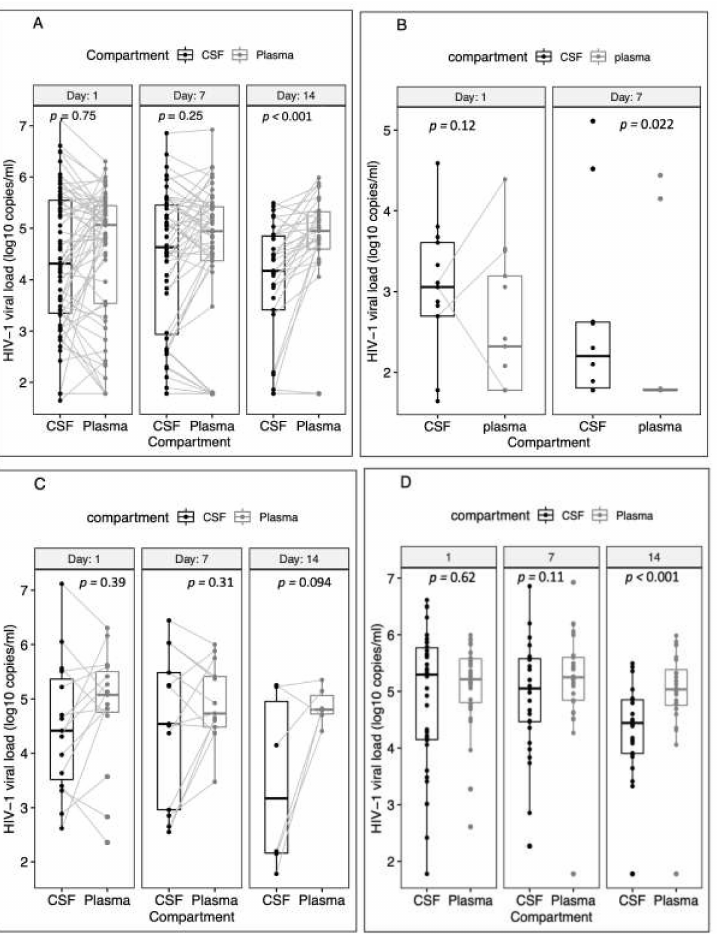
Figure 1. Comparison of median HIV-1 viral load in matched CSF and plasma samples on days 1,